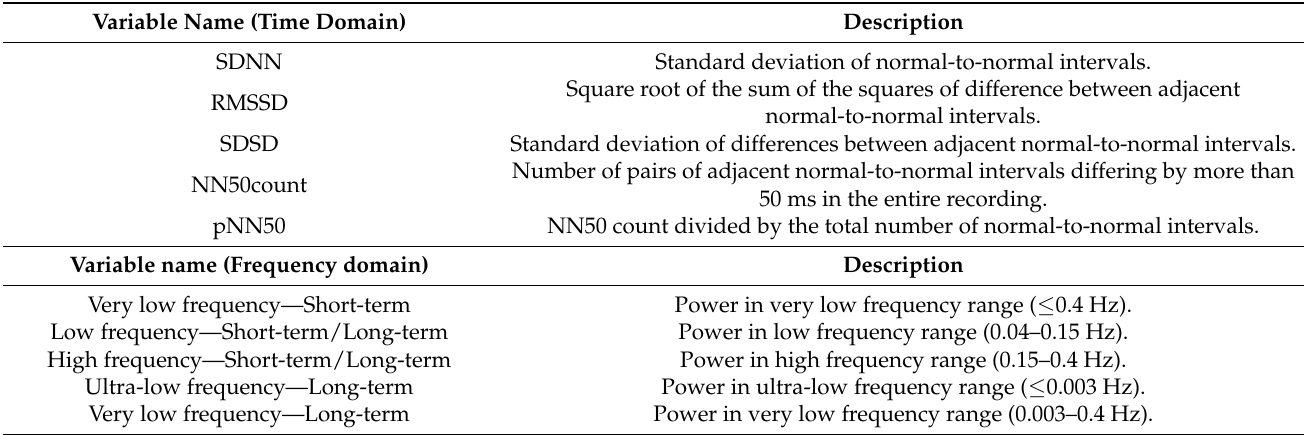
Table 1. Time and frequency domain components of HRV.